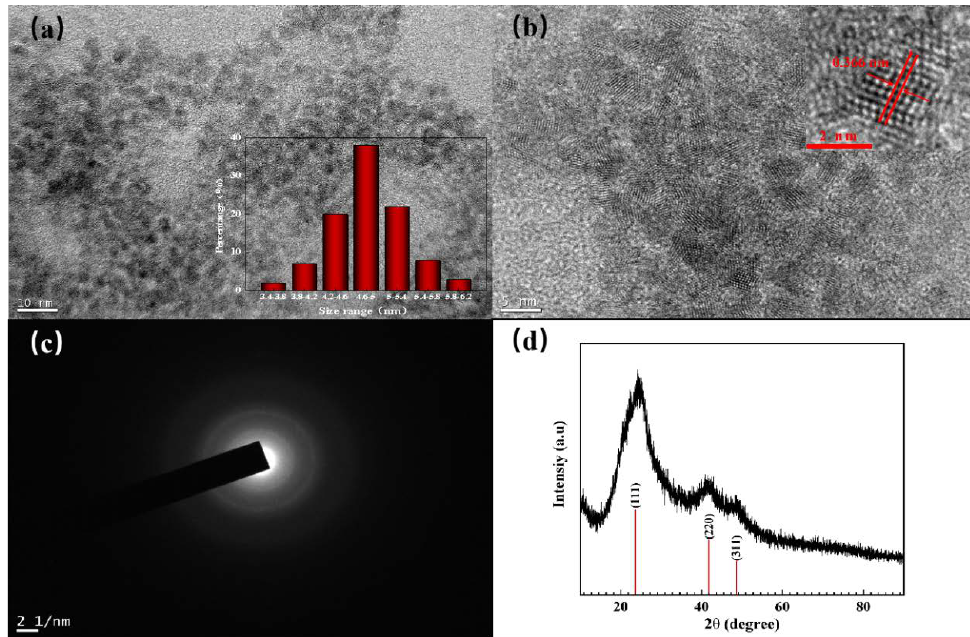
Figure 2. Characterization of GMPA@CdTe QDs. ( a ) TEM of CdTe QDs (insert: diameter distribution histogram of CdTe QDs); ( b ) HR-TEM of CdTe QDs (insert: magnified image of CdTe QD); ( c ) SAED; and ( d ) XRD pattern of CdTe QDs.